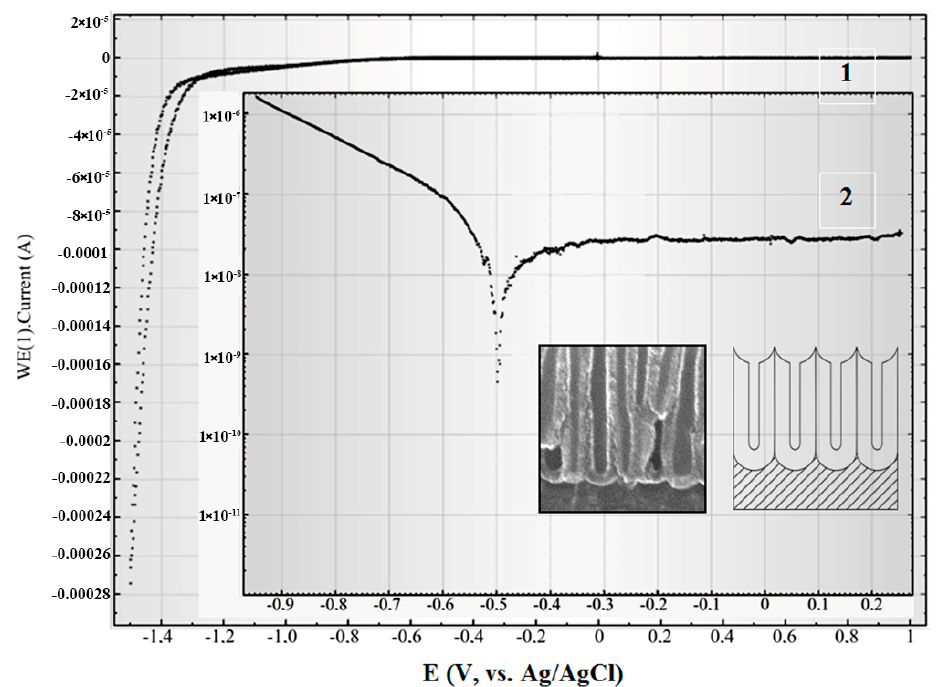
Figure 5. Cyclic (1) and linear sweep (2) voltammograms of Ti/PAAT sample in the 0.9% aqueous solution of NaCl at a potential scanning rate of 0.1 V/s.